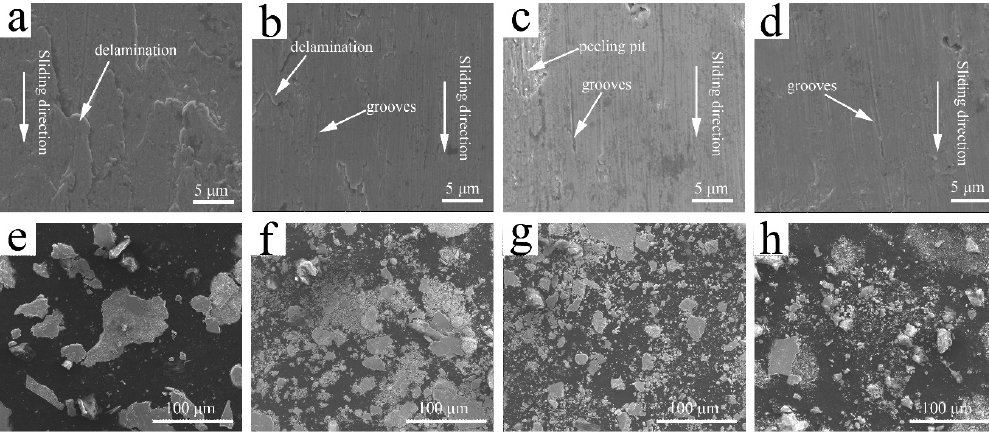
Figure 8. SEM images of the worn surface of ( a ) HEA, ( b ) HEA-10TiC, ( c ) HEA-20TiC, and ( d ) HEA-30TiC composites and corresponding debris of ( e ) HEA, ( f ) HEA-10TiC, ( g ) HEA-20TiC, and ( h ) HEA-30TiC composites after wear at room temperature. Table 3. Chemical compositions of the surface wear-tested at room temperature, in atomic